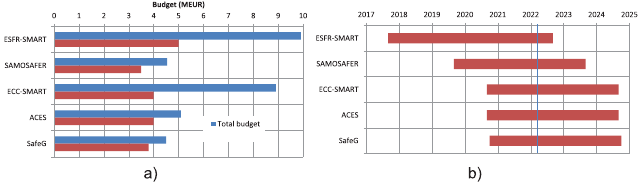
Fig. 2. Budget (a) and time span (b) of the considered EU